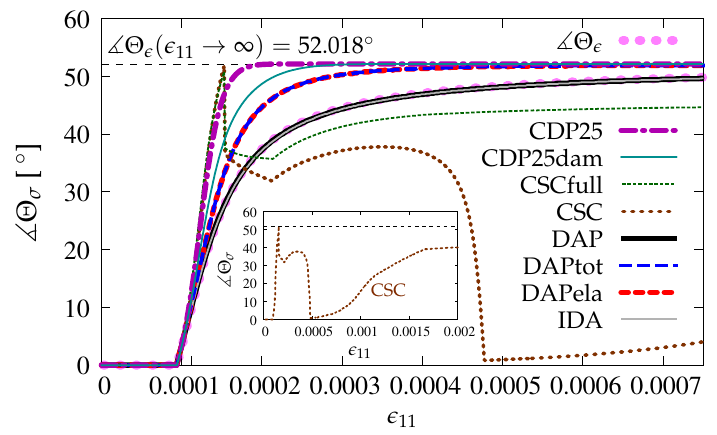
Figure 17. Comparison of models for principal directions.